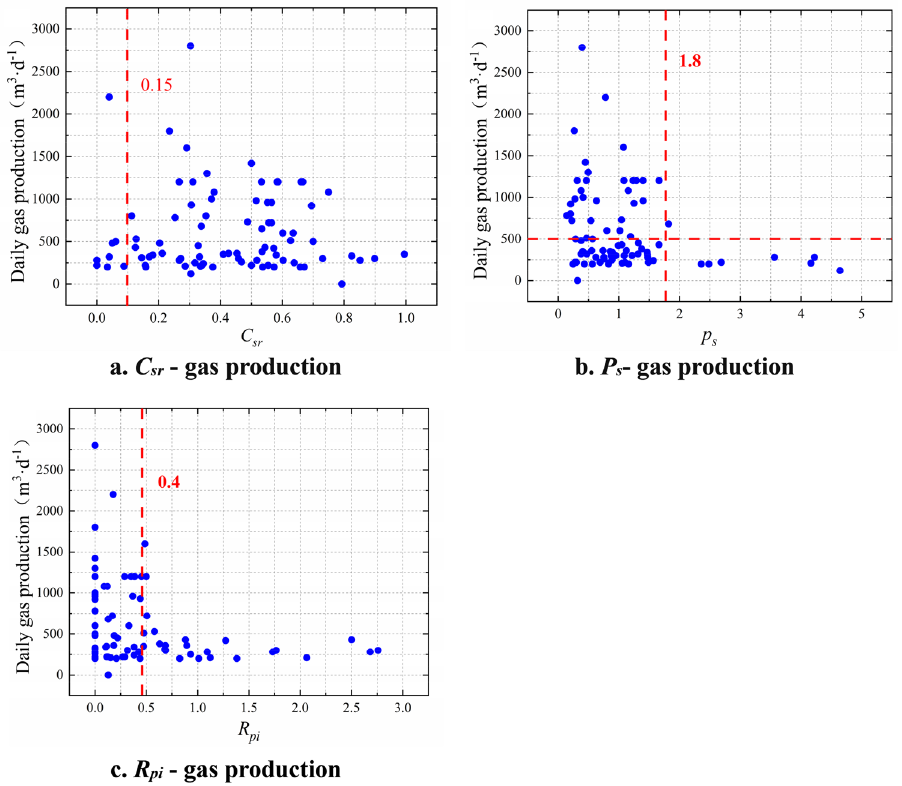
Figure 3. Determination of critical values of evaluation parameters for the effective extension length of cracks.